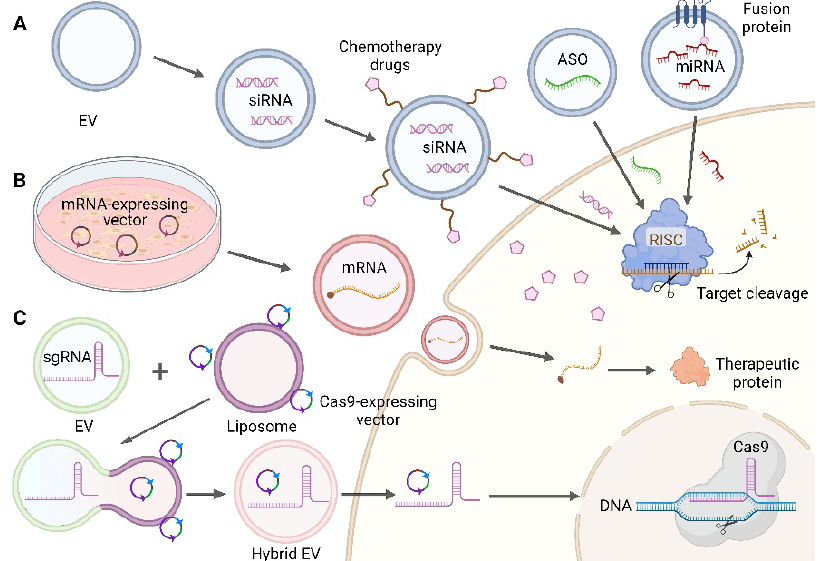
Figure 3. Several typical methods of EV loading nucleic acid. ( A ) Loading of small nucleic acid drugs: ASO, using fusion protein method to load miRNA, co-encapsulate siRNA, and